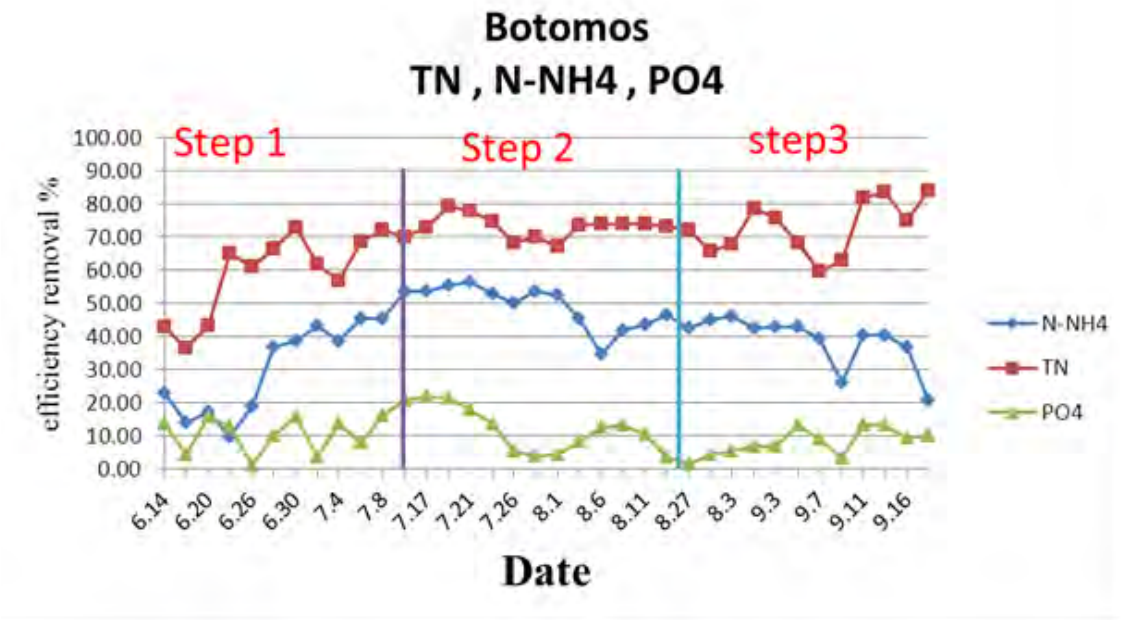
Figure 10. Effeciency removal of TN,N-NH 4 ,PO 4 IN Botomos tanks during three surface loads (8,6,4)m 3 /m 2 .h and tow circulation ratios(10%,20%) for each load and for one week time for each different load .